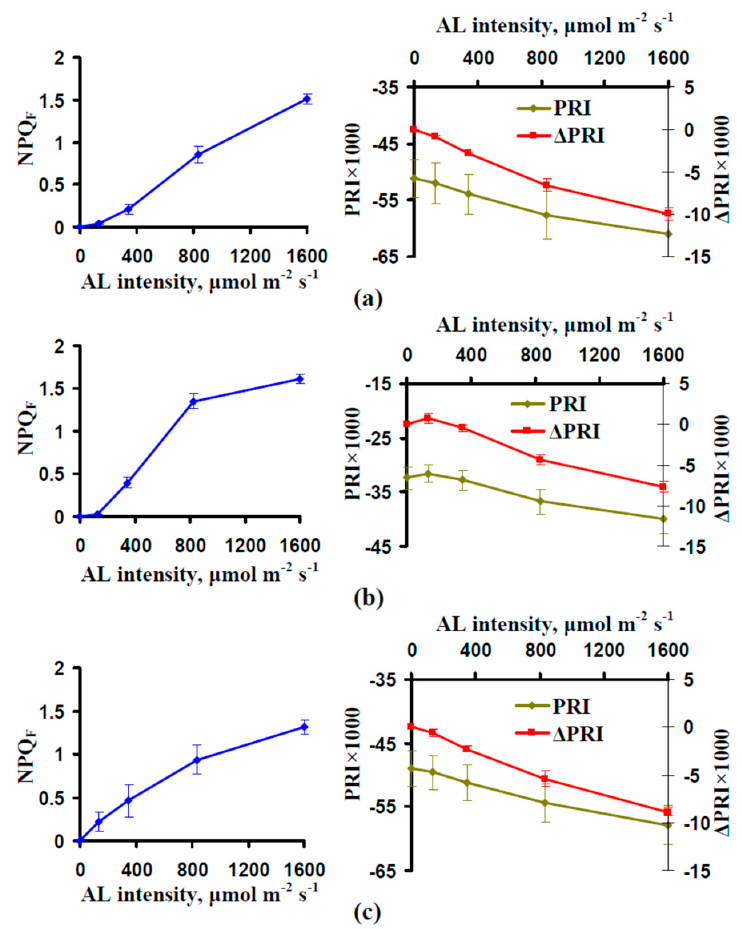
Figure 4. Dependences of the energy-dependent component of the nonphotochemical quenching of fluorescence (NPQ F ), the absolute value of the PRI and its change ( ∆ PRI) on intensity of the AL (630 nm, AL) in pea ( a ), wheat ( b ), and pumpkin ( c ) ( n = 6). Duration of illumination of each AL intensity was 5 min; the dark relaxation after that was 2 min. NPQ F was calculated as F m F m (cid:48) S were F m (cid:48) (the current maximum yield of fluorescence) before termination of the AL illumination and for 2 min after that, respectively. PRI was calculated as R 531 − R 570 R 531(570) Averaged − R 531(570) BG . R 531(570) BG is the absolute intensity of the reflected light at 531 (570) nm before the GYL pulse, R 531(570) Averaged is the averaging of the absolute intensities of the reflected light at 531 (570) nm during the GYL pulse. ∆ PRI was calculated as difference between PRI after 5 min of illumination by AL and initial PRI (without AL).